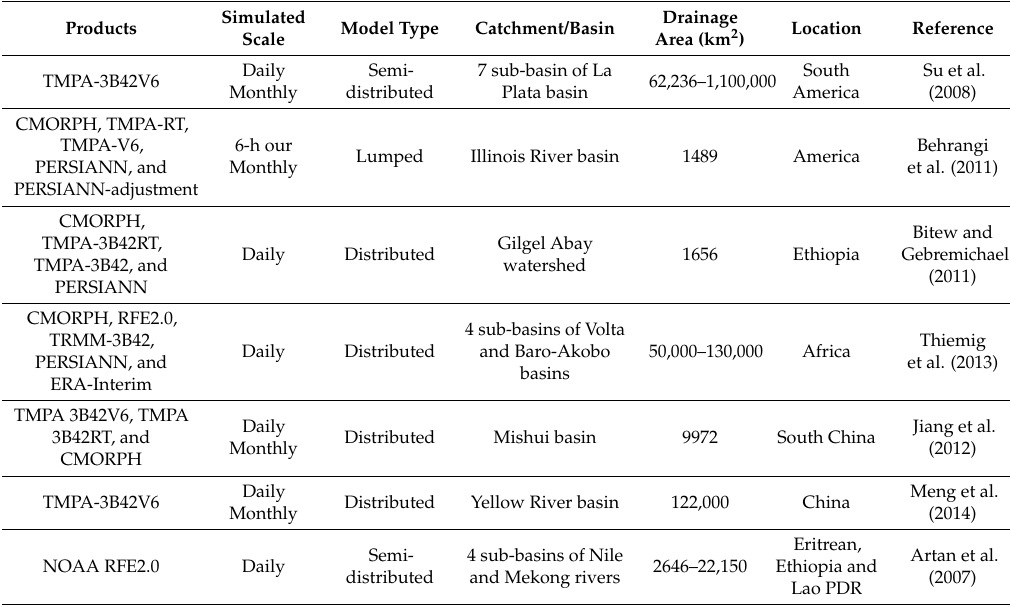
Table 2. Previous studies on hydrological modelling using satellite-based rainfall data.